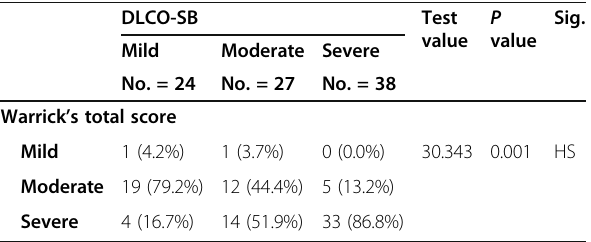
P Sig. value value